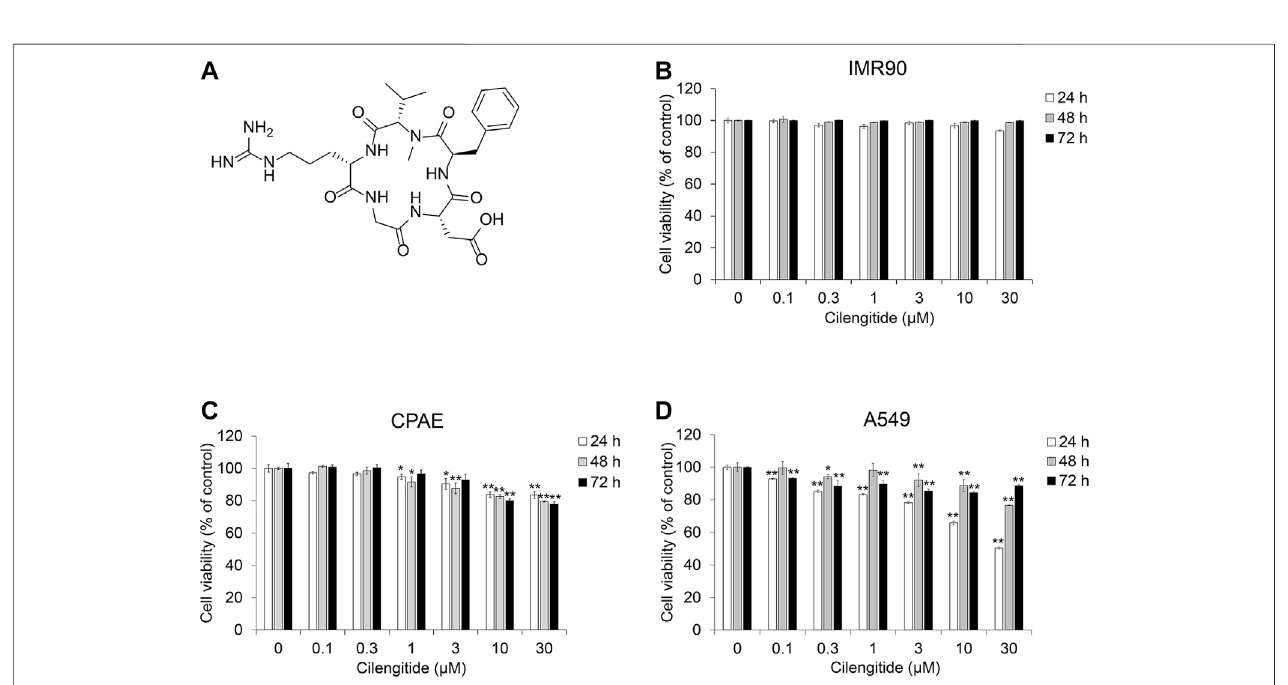
FIGURE4| CilengitideinhibitsproliferationofhumanNSCLCA549cells. (A) Chemicalstructureofcilengitide. (B) IMR90, (C) CPAEand (D) A549cellsweretreated with cilengitide for 24 – 72 h. After incubation, cell viability was measured by the CCK-8 assay. Experiments were performed in triplicate. Data represent mean ± SD. * p < 0.05, ** p < 0.01 vs. untreated